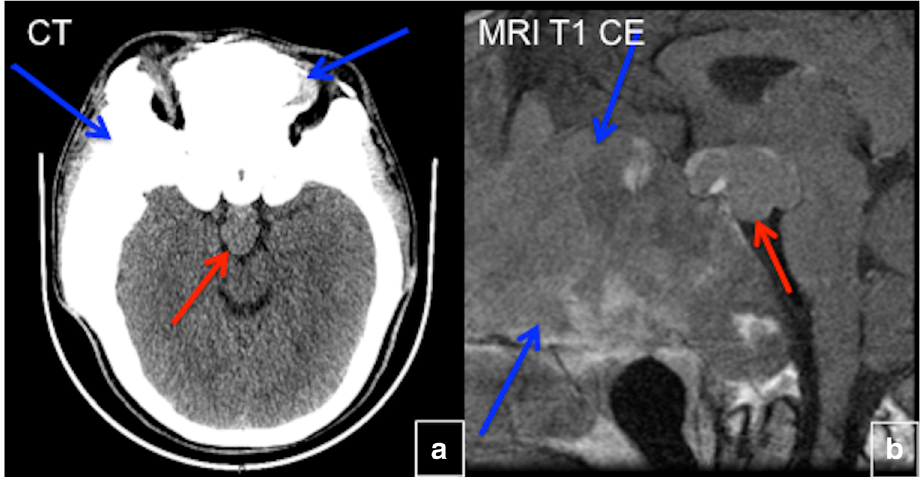
Fig. 27 Pituitary adenoma in craniofacial fibrous dysplasia (FD). a , b A patient with craniofacial FD ( blue arrows ) with pituitary macroadenoma ( red arrows ) on CT ( a ) and T1 contrast-enhanced MRI ( b